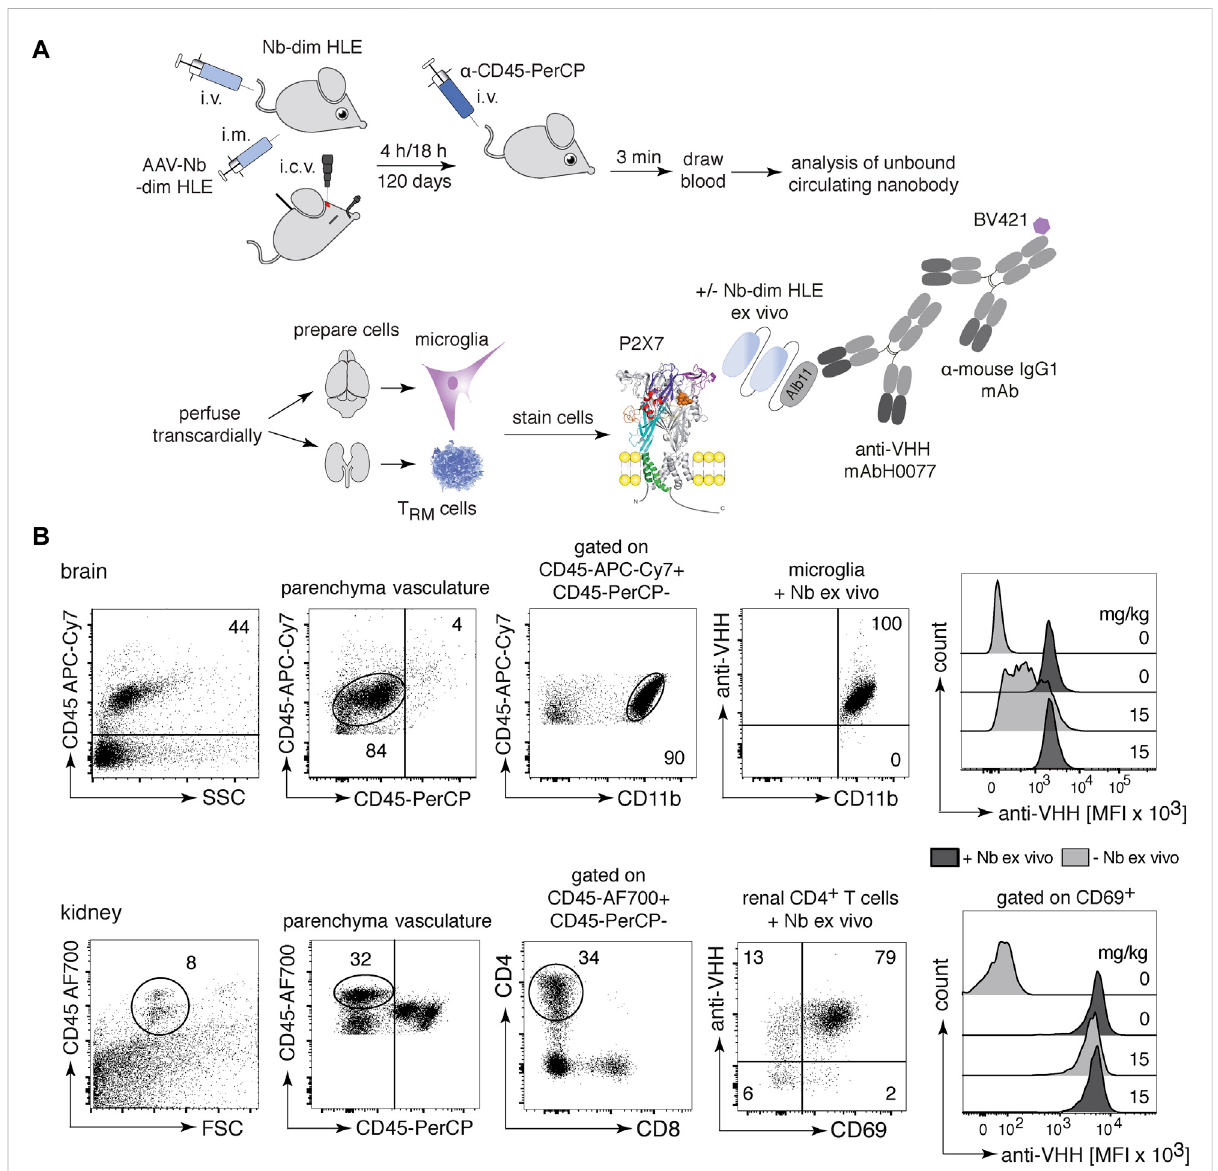
FIGURE 2 Invivo occupancyofcellsurfaceP2X7byinjectedbivalentHLEnanobodies. (A) Theschemeillustratestheexperimentalset-uptodeterminethe level of target occupancy of P2X7 in different tissues using different routes of administration of P2X7-speci fi c nanobodies. Bivalent HLE nanobodies were injected either i.v. or i.c.v. into mice and sacri fi ced after 4 h or 18 h. In addition, a single i.m. injection of nanobody-encoding AAV was performed for endogenous production of nanobodies, and mice were sacri fi ced after 120 days. Prior to sacri fi ce, a CD45-speci fi c mAb was injected i.v. to stain vascular leukocytes. A blood sample was obtained to determine the level of unbound nanobodies in serum and vascular nanobodies were removed by transcardial perfusion. Brain and kidney cell suspensions were analyzed for cell surface-bound nanobodies by detection with anti-HHV mAbH0077 followed by BV421-conjugated mouse IgG1-speci fi c mAb. As control, cells were incubated ex vivo with a saturated dose of the same nanobody (+Nb-dim HLE ex vivo ) to assess the maximal level of P2X7 occupancy. (B) Parenchymal brain cells (top) were detected with a second CD45-speci fi c mAb and microglia were identi fi ed as the parenchymal CD45 int /CD11b hi population. Renal parenchymal cells (bottom)weredetectedwithasecondCD45-speci fi cmAbandtissueresidenthelperTcells(T RMs )wereidenti fi edastheparenchymalCD45 hi /CD4 + / CD69 + population. Histogram overlays show the MFI of BV421-stained-nanobodies bound to P2X7 on microglia and T RMs 4 h after i.v. injection of 15 mg/kg bivalent HLE nanobodies, controls from non-injected mice. Data are representative of three independent experiments. Dot plots shown are from a single mouse. An independent experiment refers to an experiment with a single mouse per condition, in which all mice were analyzed on the same